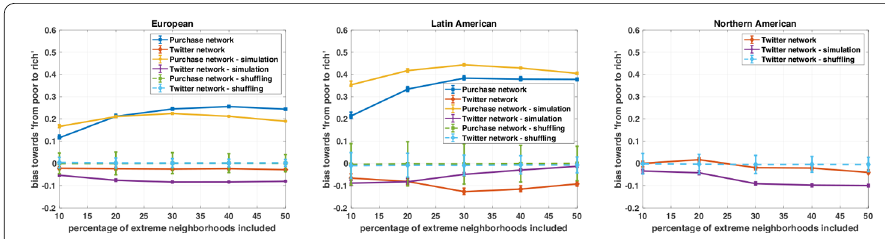
Figure 4 Asymmetry in the interaction patterns between the relatively poor and the relatively rich segments of the population. The error bars correspond to the 95% confidence interval using a jackknife resampling technique as in